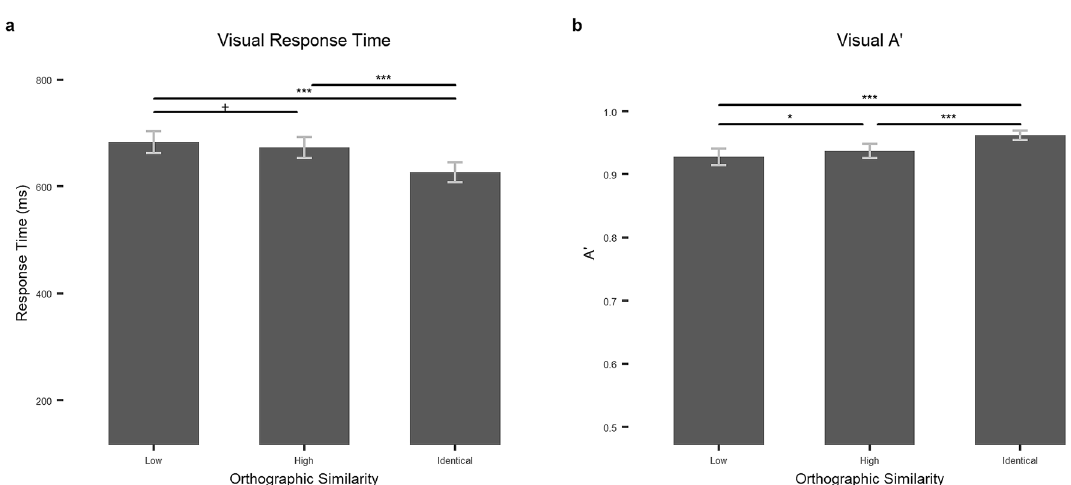
Figure 5. The effects of orthographic similarity on the lexical decision task in the visual modality. ( a ) Response times in miliseconds and ( b ) A’ by orthographic similarity (low, high, and identical) for the visual task. Error bars stand for 95% confidence intervals. N.s.: p > .1; + : p < .1; *: p < .05; **: p < .01, ***: p <